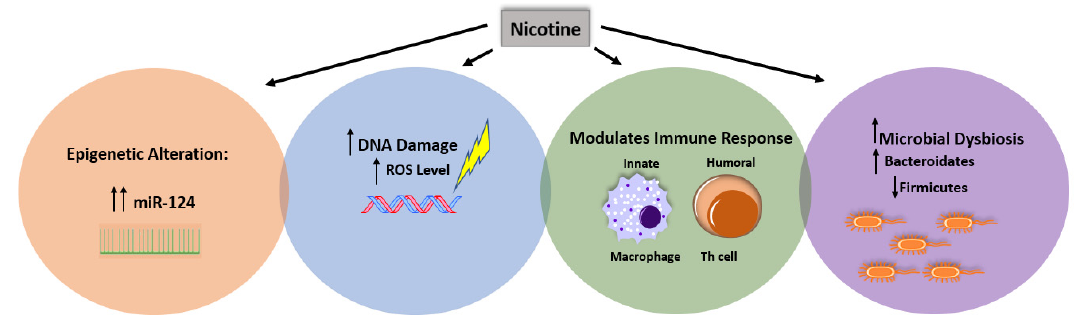
Figure 1. Effect of multi ‐ factorial interaction and nicotine on IBD pathogenesis. Illustration of how nicotine may regulate the pathogenesis of IBD by stimulating DNA damage in intestinal cells, inducing microbial dysbiosis and increasing susceptibility to infection, increasing the probability of epigenetics, and modulating intestinal immune response.